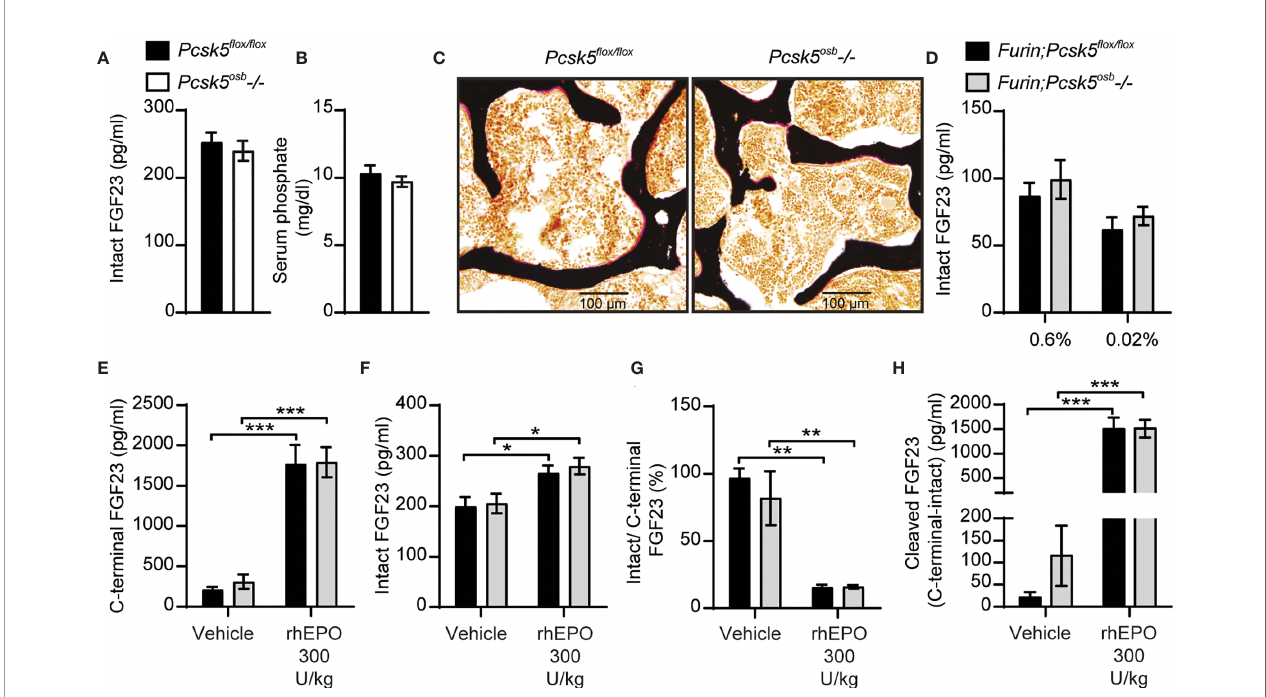
FIGURE 6 | Genetic ablation of PC5 alone or in combination with Furin does not impair FGF23 processing in vivo . Plasma intact FGF23 (A) and serum phosphate levels (B) in 4-month-old Pcsk5 fl ox/ fl ox (n=6) and Pcsk5 osb -/- (n=7) mice fed a normal chow diet. (C) Von Kossa/van Gieson staining of vertebrae sections of Pcsk5 fl ox/ fl ox and Pcsk5 osb -/- . (D) Plasma intact FGF23 in 6-month-old Furin;Pcsk5 fl ox/ fl ox (n=7-8) and Furin;Pcsk5 osb -/- (n=8) fed a normal phosphate diet (0.6%) or a low phosphate diet (0.02%) for one week. (E, H) Plasma FGF23 measurements in 4-month-old Furin;Pcsk5 fl ox/ fl ox (n=4) and Furin;Pcsk5 osb -/- (n=4) 6 hours following an injection of vehicle and 300 U/kg of recombinant human erythropoietin (rhEPO): C-terminal FGF23 (E) , intact FGF23 (F) , percentage (%) of intact over C-terminal FGF23 (G) and cleaved FGF23 levels (H) , calculated as (C-terminal FGF23) - (intact FGF23). Results represent the mean ± SEM. * P < 0.01, ** P < 0.01 and *** P < 0.001, by 2-way ANOVA with Bonferroni ’ s multiple comparisons test, or by Student ’ s t-test (A, B)